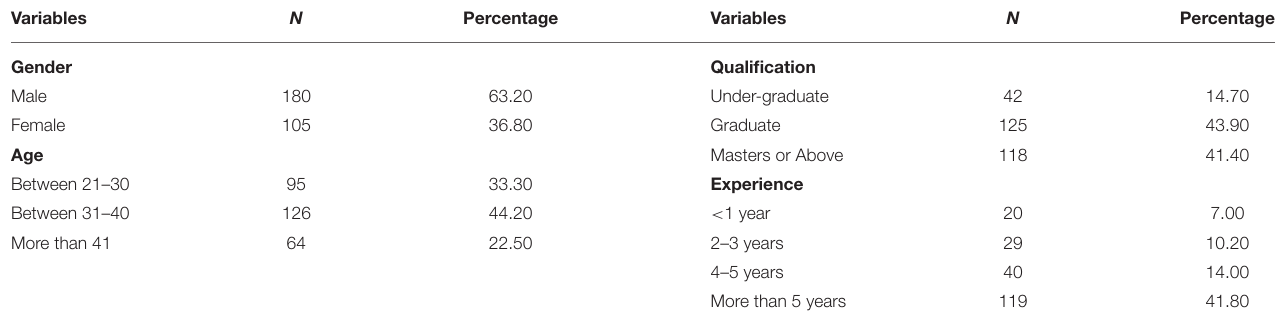
TABLE 2 | Results of measurement analysis. Constructs